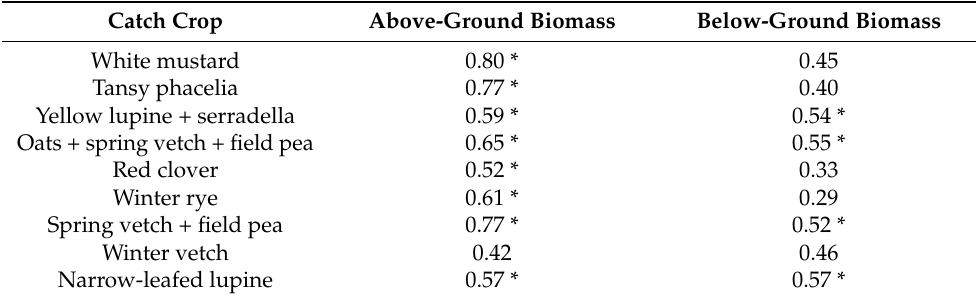
Table 3. Correlation coefficients (r) between above and below-ground biomass yields and CO 2 sequestration in the biomass. Catch Crop Above-Ground Biomass Below-Ground